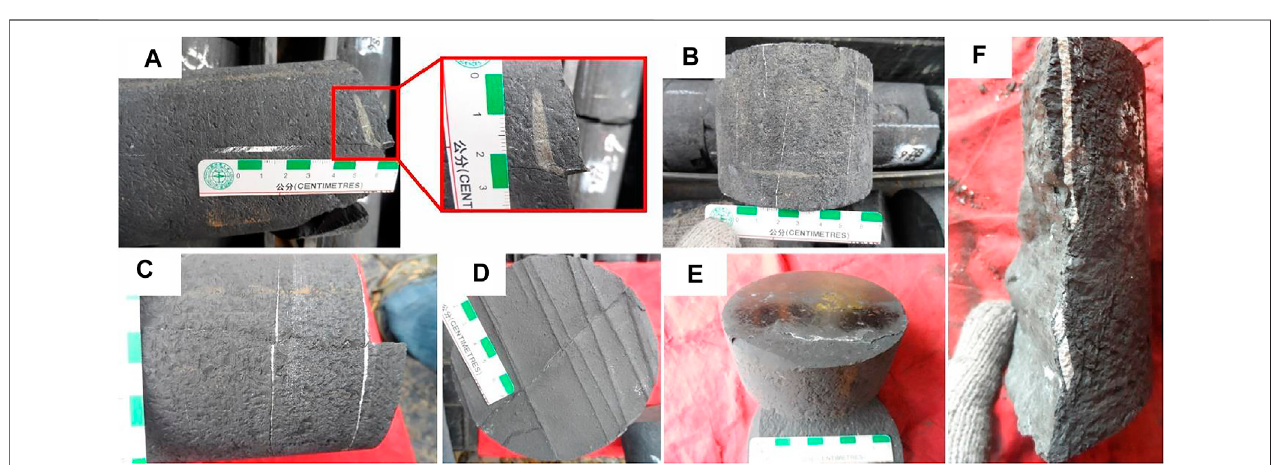
FIGURE 15 | Geometries of intersection relationship between shale fractures in Cen ’ gong block. (A) One tip of horizontal pyrite- fi lled fracture is upwarped by subverticalcalcite- fi lledfracture; (B) subverticalfracturecuttingacrossthehorizonal pyrite- fi lledfracture; (C) onesubverticalfracturecuttingacrosstwobedding-parallel fi brous veins; (D) intersection relationships between twosubvertical fracturegroups, and the included angle isabout 60 ° ; (E) mirror structure ofslip fracture ison the top of calcite fi llings of bedding-parallel fi brous vein; (F) subvertical slip fracture developed along the previous calcite- fi lled fracture.